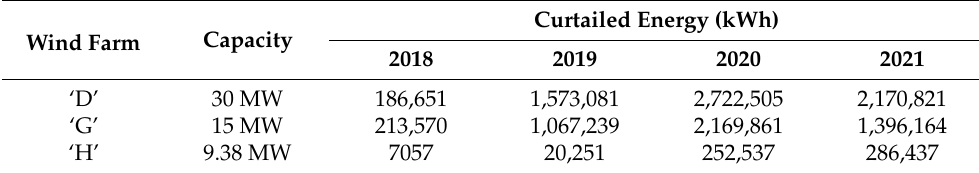
Table 30. Annual curtailment record for “H” and neighbor wind farms [4,28].